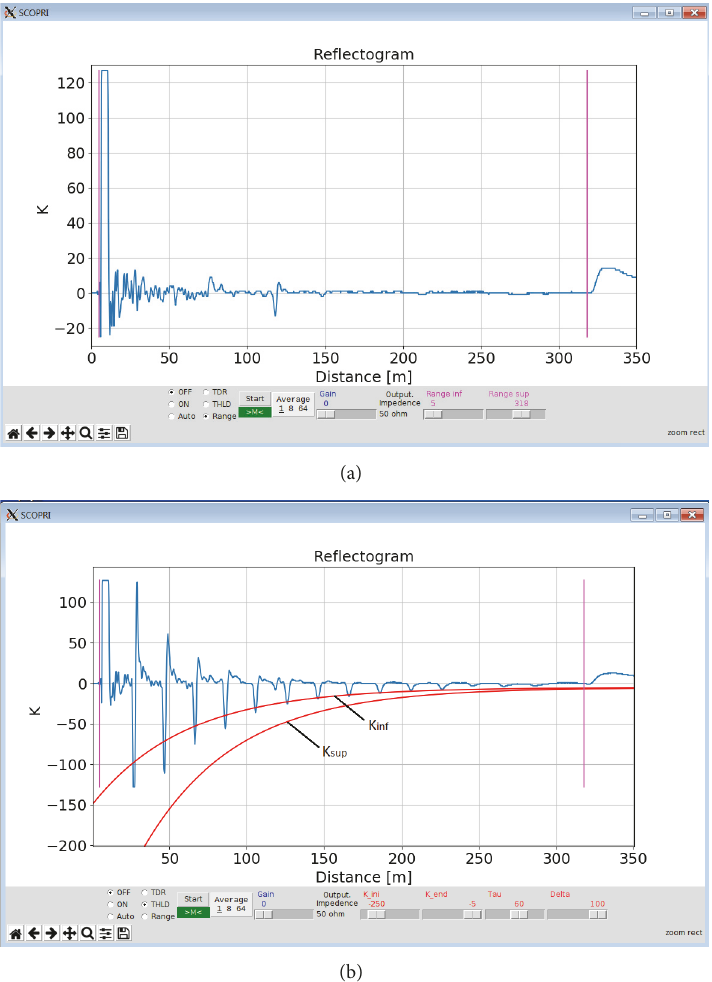
Figure 5: Experiment #1: (a) reflectogram acquired in dry condition; (b) reflectogram acquired after drip irrigation. The threshold curves for K are also